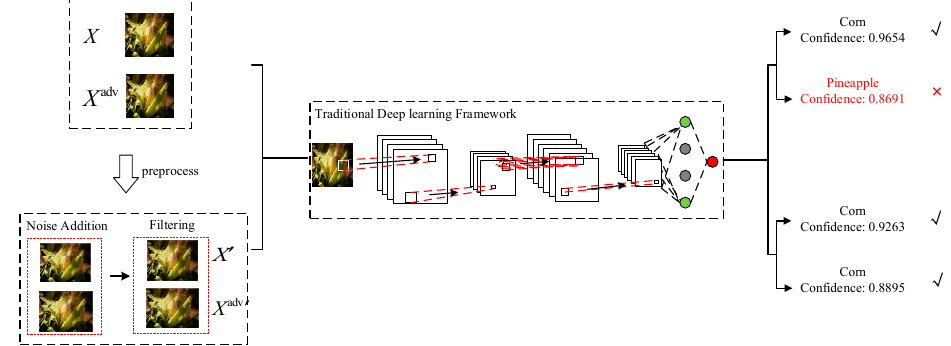
Figure 3. The adversarial perturbation elimination framework.